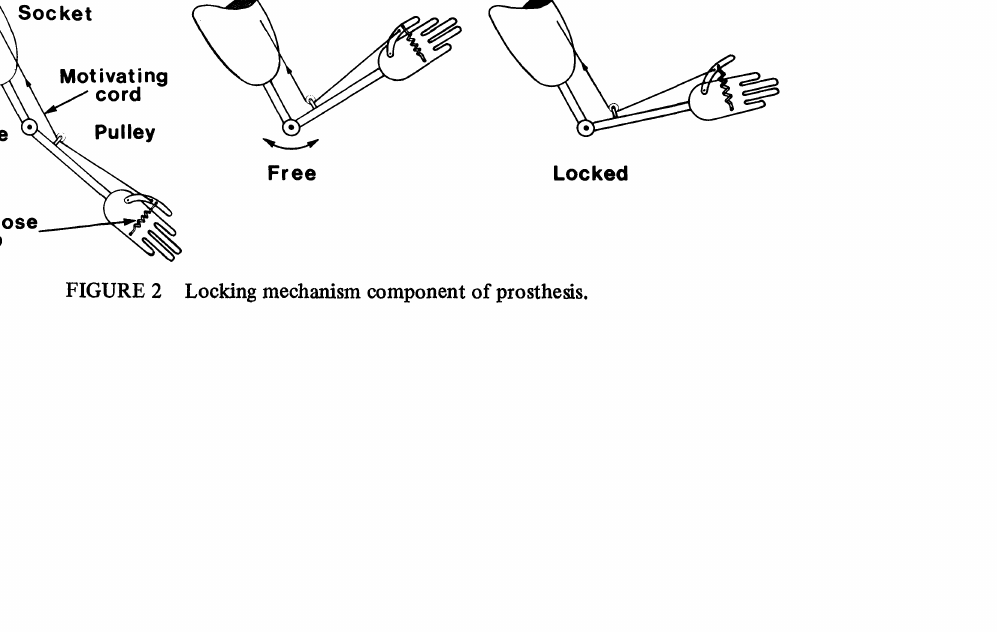
FIGURE 2 Locking mechanism component of